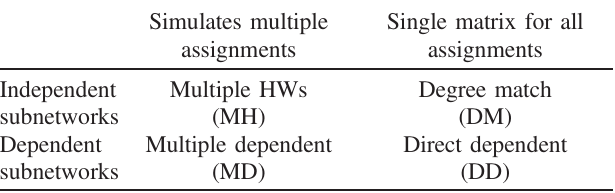
TABLE IV. A summary of the key features of the four methods developed to simulate networks of student collaboration. The row for independent and dependent subnetworks refers to whether the got-help and helped matrices were created independently or whether the helped matrix depended on the got-help matrix. Simulates multiple Single matrix for all assignments